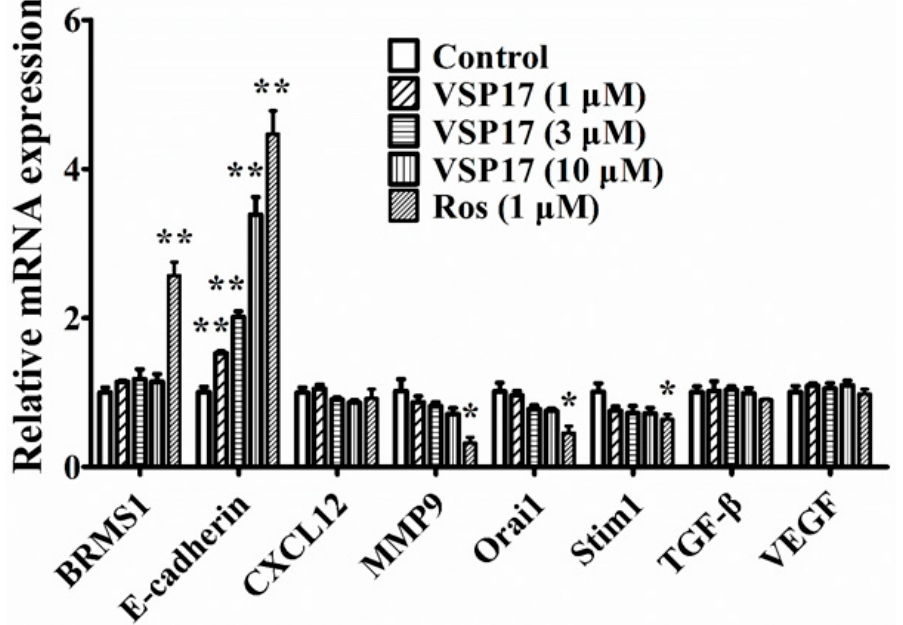
Figure 2. Effect of VSP-17 on metastasis-related factors in MDA-MB-231 cells. MDA-MB-231 cells were treated with VSP-17 (1, 3, and 10 μ M) for 24 h, and the mRNA expressions of breast cancer metastasis suppressor 1 (BRMS1), E-cadherin, CXCL-12, metal matrix proteinase 9 (MMP9), calcium release-activated calcium channel protein 1 (Orai1), stromal interaction molecule 1 (Stim1), transforming growth factor (TGF- β ), and vascular endothelial growth factor (VEGF) were measured using a Q-PCR assay. The data were expressed as the means ± S.E.M. of three independent experiments. * p < 0.05, ** p < 0.01 vs. control.